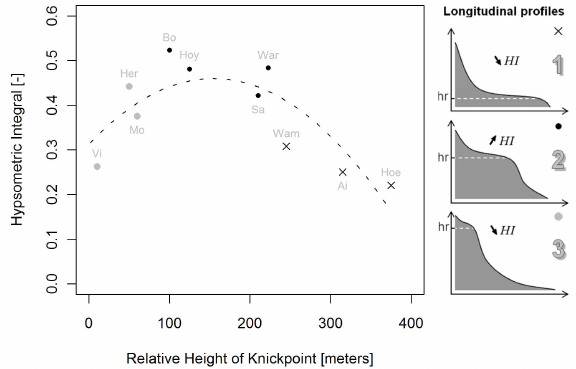
Fig. 5. Nonlinear relation between the relative height of the channel convexity (Rch) and the hypsometric integral (HI). Three phases of knickpoint upward migration are represented in the right